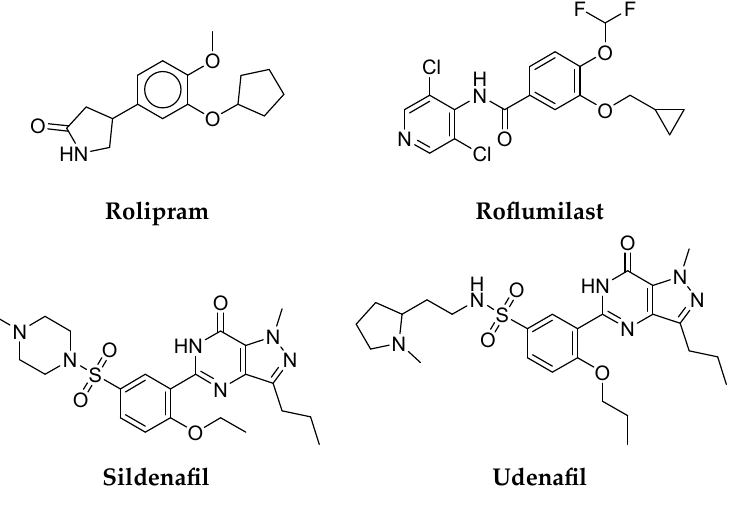
Figure 6. Repurposed PDE inhibitors.